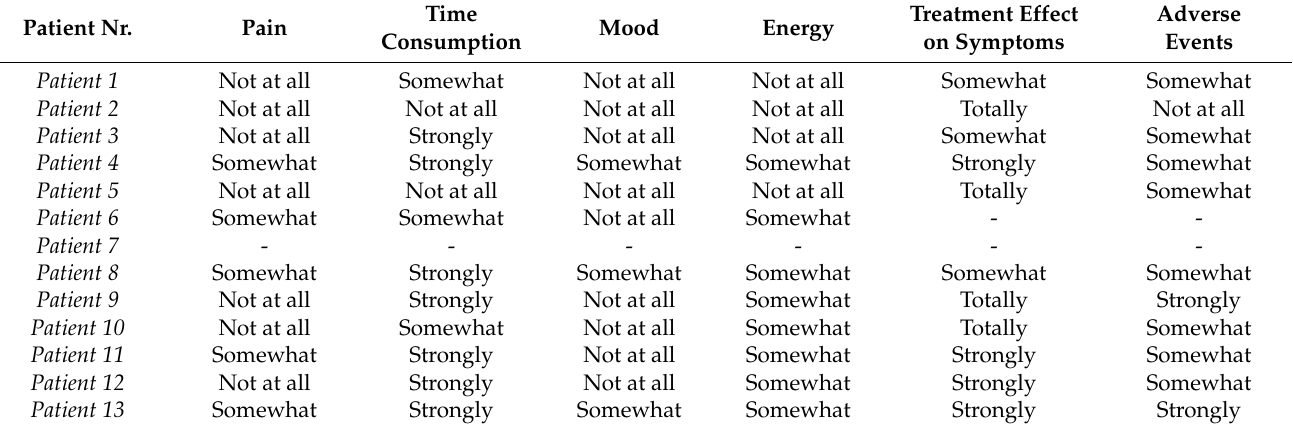
Table 3. Patients’ expectations at the start of the study period in 6 different domains ranging from “not at all” and “somewhat” to “strongly” and “totally”.